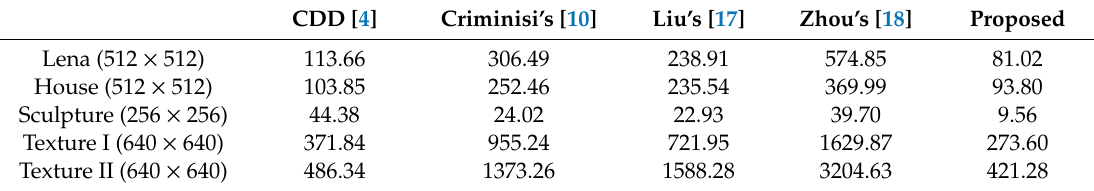
Table 3. Running time (s) comparison of Figure 7, Figure 8, Figure 9, Figure 10 and Figure